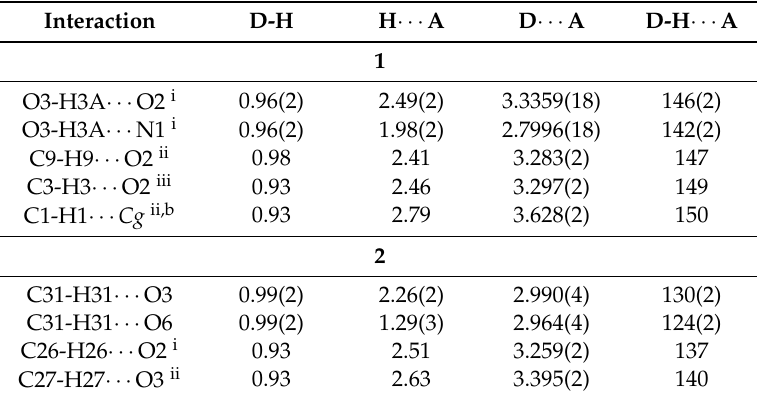
Table 2. The geometries of intermolecular interactions of 1 and 2 a .